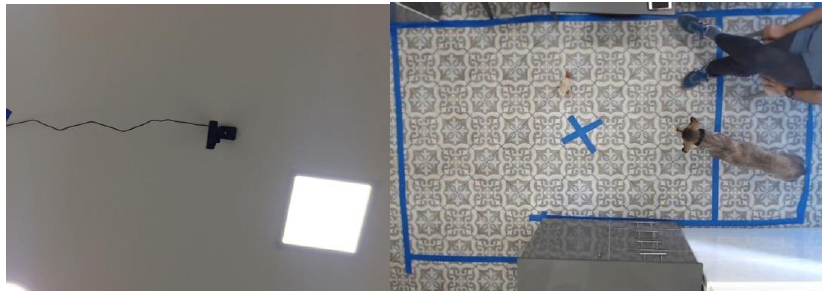
Figure 2 . Camera fixed on the ceiling in Tel Aviv clinic and an example